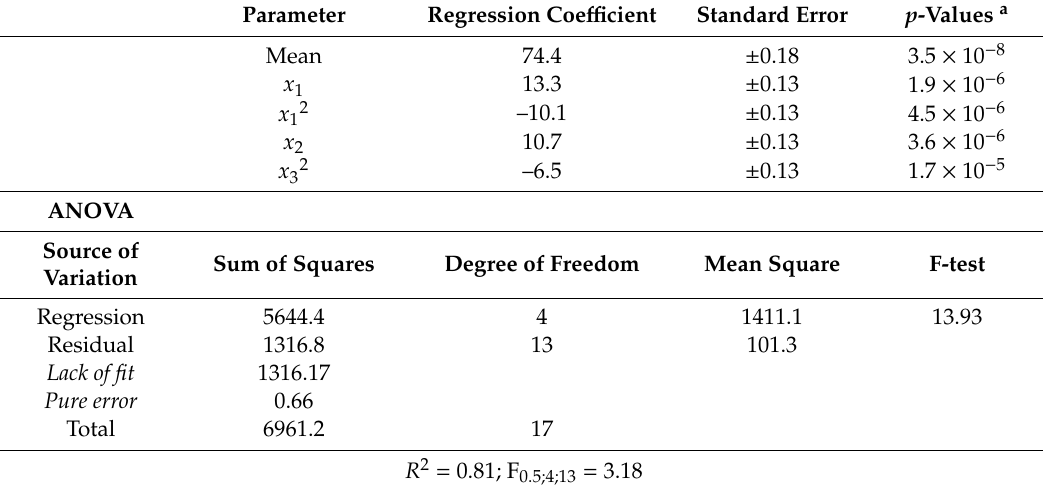
percentage in solketal palmitate synthesis.